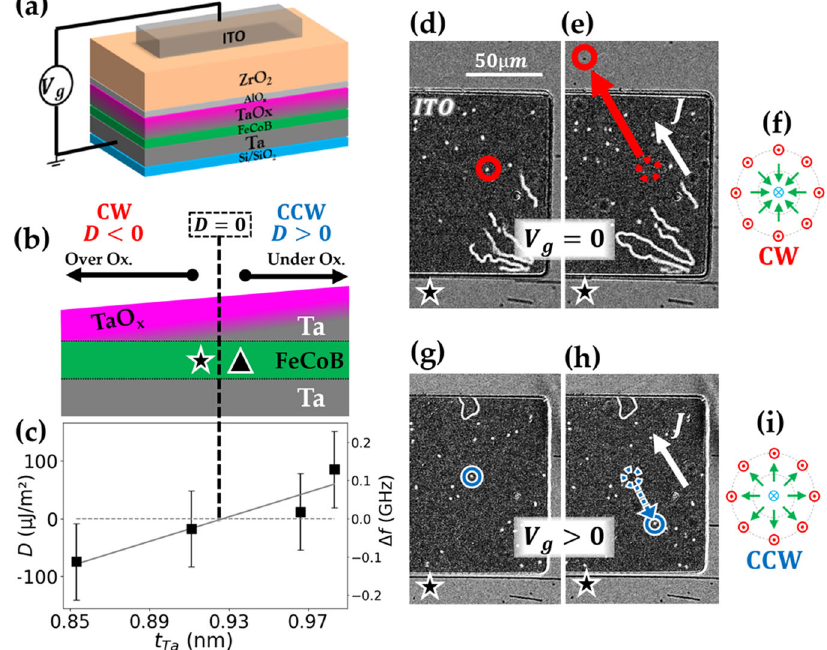
Fig. 1 | Skyrmion chirality reversal. a Schematicrepresentation ofthe Ta/FeCoB/ TaO x trilayer with additional ZrO 2 oxide and transparent ITO electrode for gate voltage application. b Schematic cross section of the sample: the top-Ta wedge induces an oxidation gradient at the top interface, leading to c a iDMI sign cross- over as directly measured by BLS vs. top-Ta thickness. Error bars of±100MHz on the frequency difference Δ f , represented on the right axis, are due to the setup. d , e CIM monitored during 4s under p-MOKE microscope at the star location shownon b forzero gate voltage and g , h for V g =+3.5V,applied on ITO(the dark